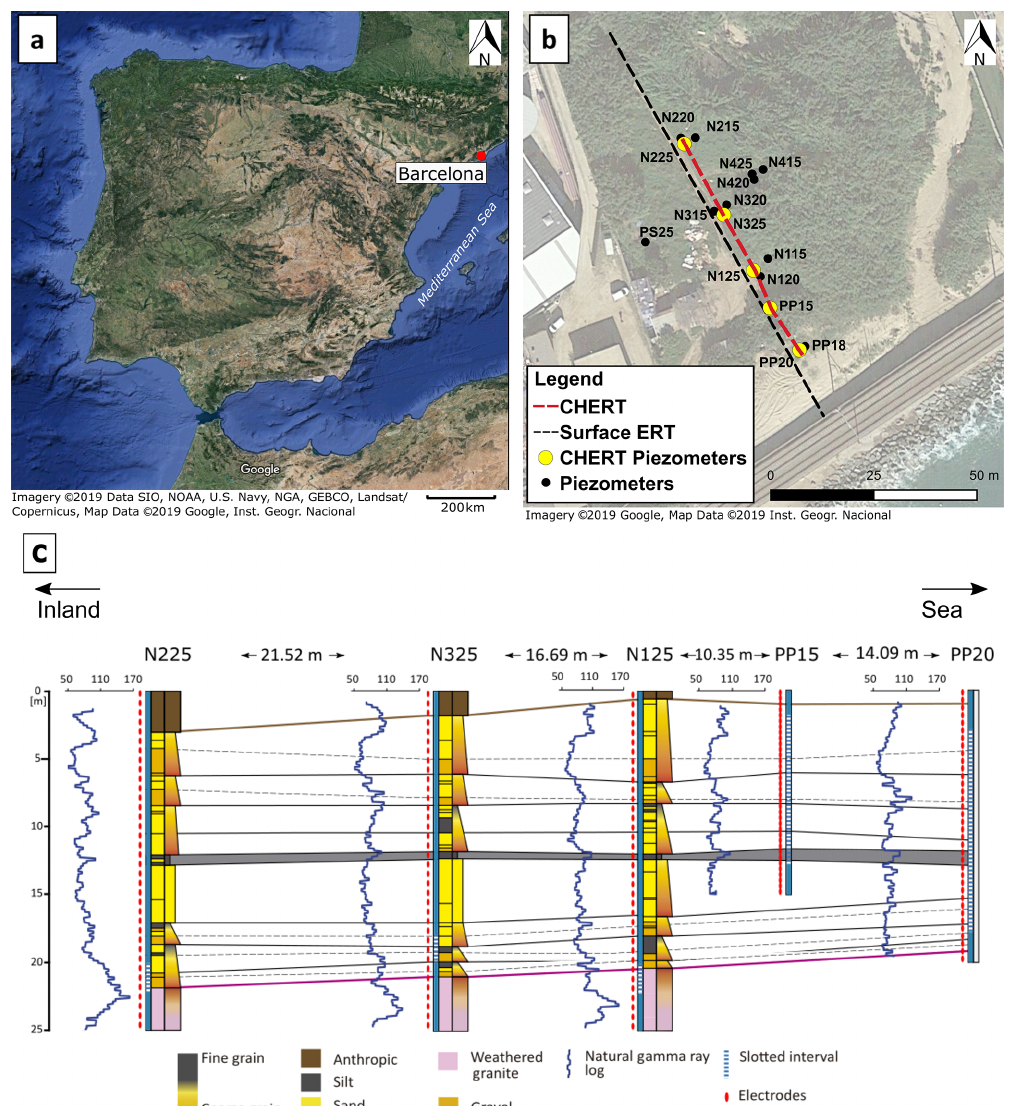
Figure 1. (a) Location map of the Argentona site, some 30km northeast of Barcelona, Spain. (b) Field spread of the Argentona site, installed piezometers (black dots), piezometers equipped with electrodes (yellow dots), surface ERT and CHERT transects. (c) Vertical cross section showing piezometers with screened depth, and location of the 36 electrodes in each well and stratigraphic correlation (modified from Martínez-Pérez et al., 2018). Two sandy aquifers are loosely separated by a silt layer at 12m depth. The semiconfined aquifer is underlaid by weathered